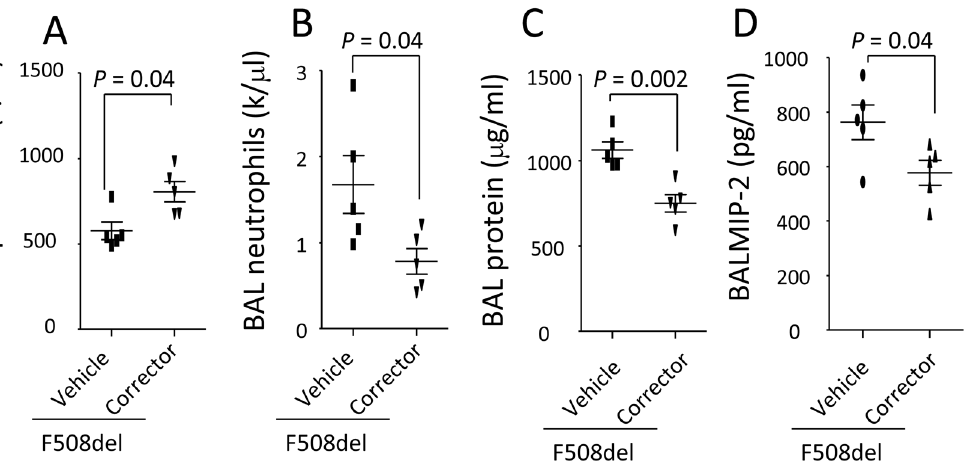
Figure 7. Correction of F508del CFTR trafficking by KM 11060 prevents thrombocytopenia in F508del and lung inflammation induced by LPS. A. Correction of F508del CFTR trafficking by KM11060 prevented thrombocytopenia. B–D. Rectification of F508del CFTR trafficking by KM11060 reduced BAL neutrophils (B), protein levels (C), and MIP-2 levels (D) in F508del mice under LPS challenge. N=5 in each group. Data were analyzed by t-test and presented in mean 6 SD. P values are listed on each panel.